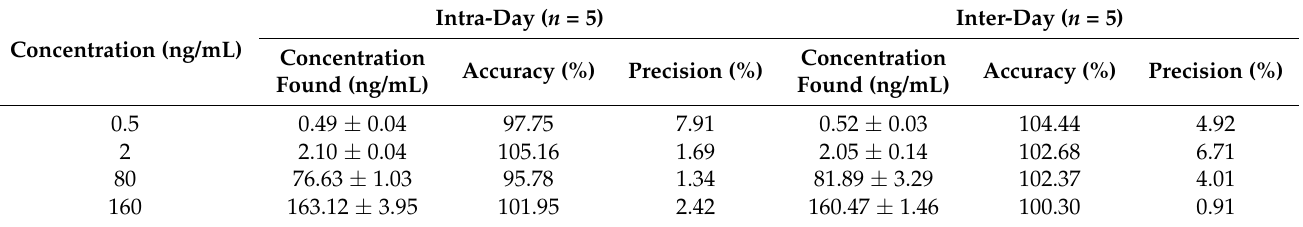
Table 4. Intra- and inter-day accuracy and precision of nafamostat in the rat plasma (mean ± SD, n = 5).